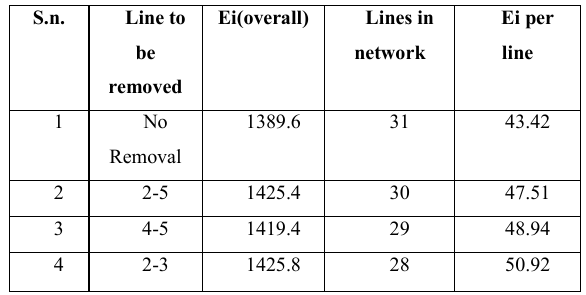
Fig10. Graph for average Economic index with removed line corresponding to E i order.